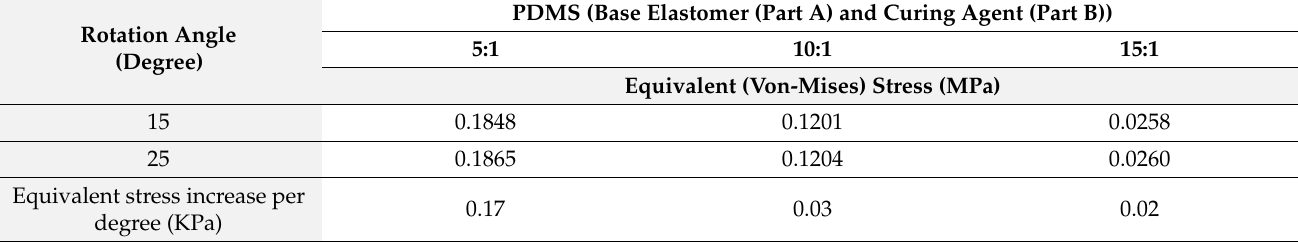
would increase, as shown in Table 3. Table 3. Effects of rotation angles on the maximum mold stress within the elastic range of PDMS at different composite Table 1. Stretching test to test the elastic range of PDMS at three different ratios.